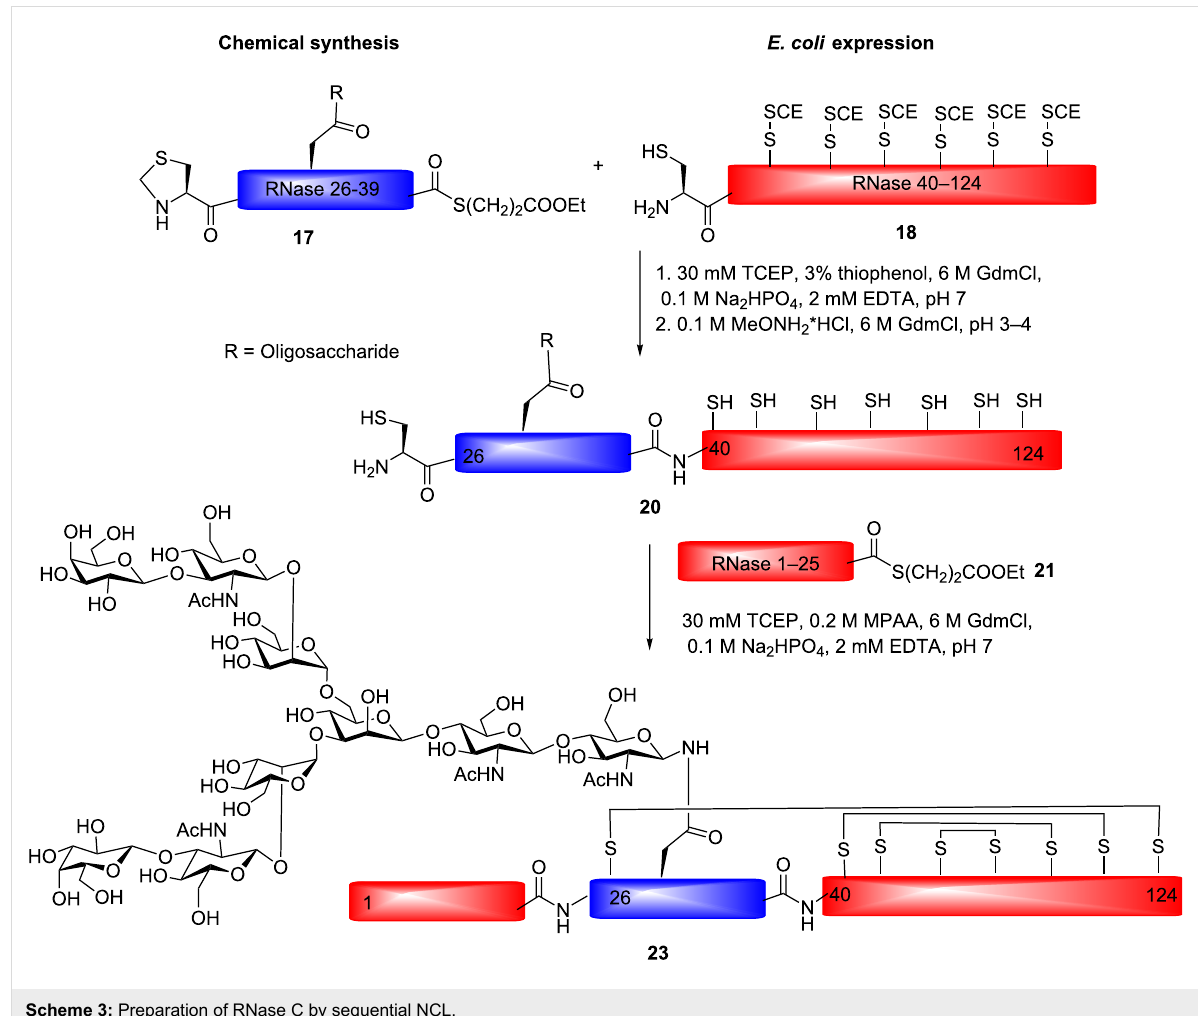
Scheme 3: Preparation of RNase C by sequential